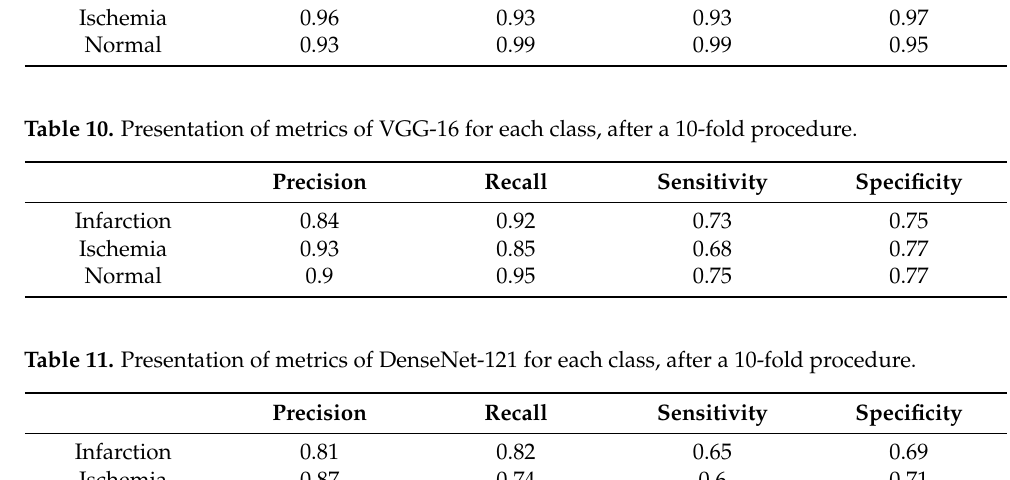
Table 9. Presentation of metrics of proposed RGB for each class, after a 10-fold procedure. Precision Recall Sensitivity Specificity Infarction